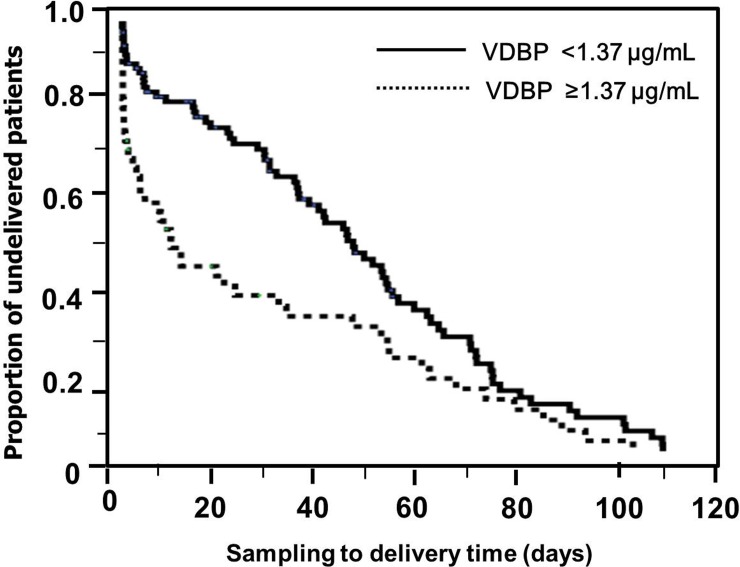
Kaplan-Meier survival estimates of the sampling-to-delivery interval according to the levels of vitamin D-binding protein (VDBP) in the cervicovaginal fluid of women with preterm labor and intact membranes (using 1.37 μg/mL as a cut-off) (median, 9.91 days [95% confidence interval (CI), 5.17–14.65] vs. 45.87 days [95% CI, 36.84–54.90]; P = 0.003).